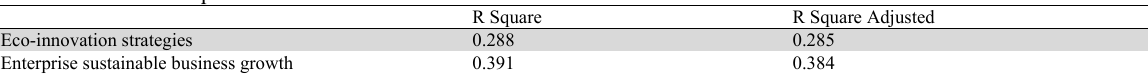
The results of the R-Square